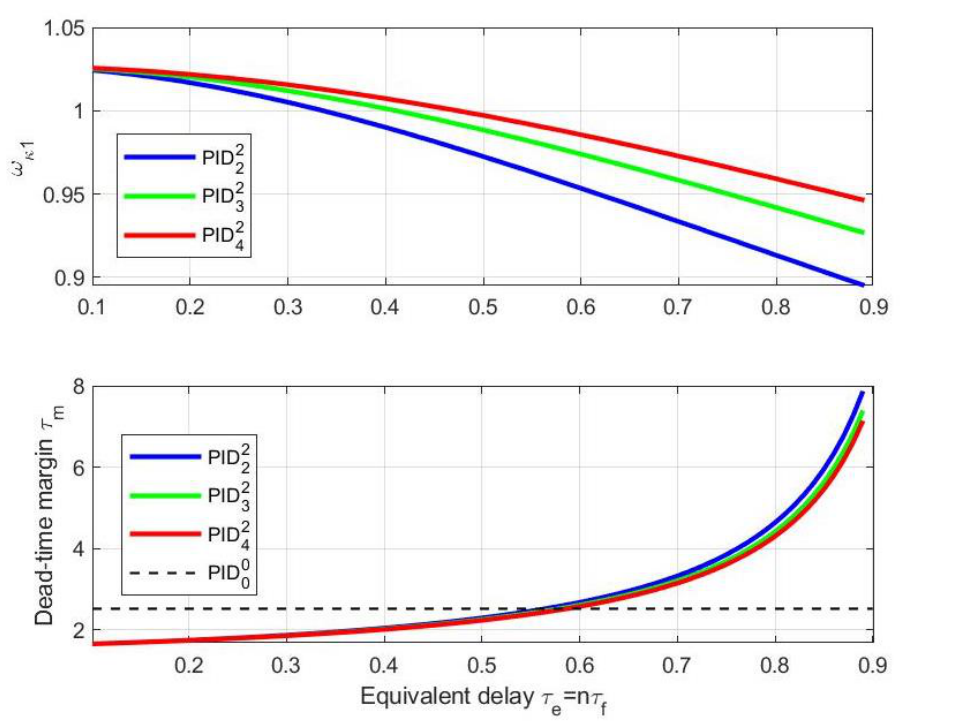
Figure 11. Calculating the gain margin κ m of the filtered PID 2 T dp = 1 and the T f = T e / n tuning equivalence, n = 2,3,4.